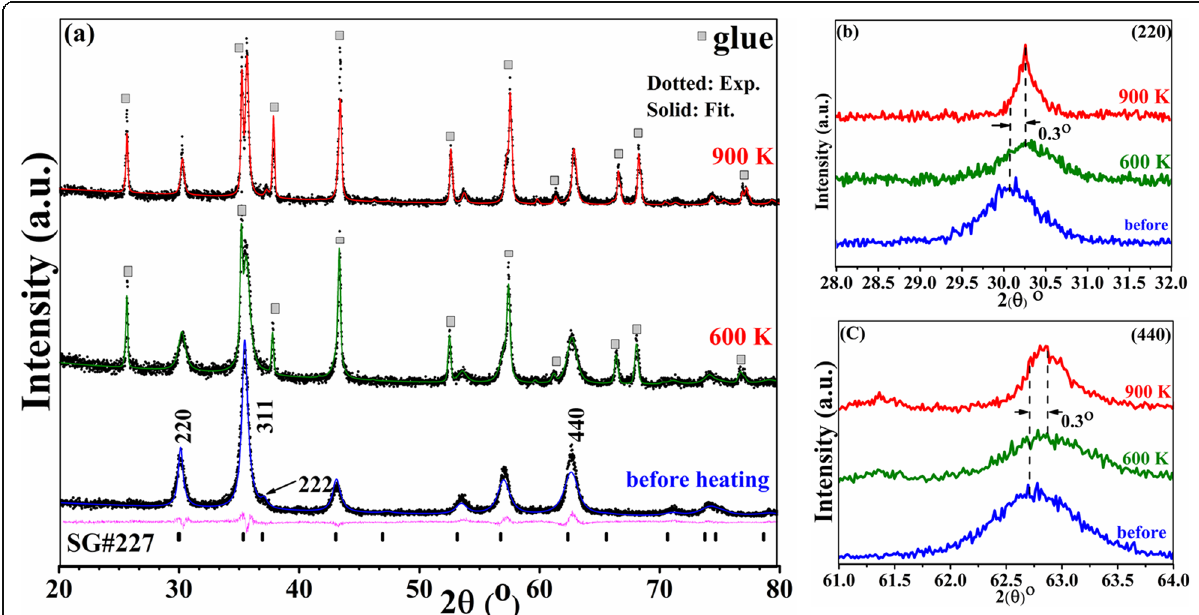
Fig. 4 a XRD patterns for pristine Fe 3 O 4 before heating and after heating to 600 K (green), 900 K (red) (black dotted line, experimental data; solid line, fitted; magenta, difference; pars, SG #227 phase) (the small filled squares represent the peaks for the glue used for high-temperature VSM measurements), b enlarge pattern for (220) peak, and c enlarge pattern for (440)